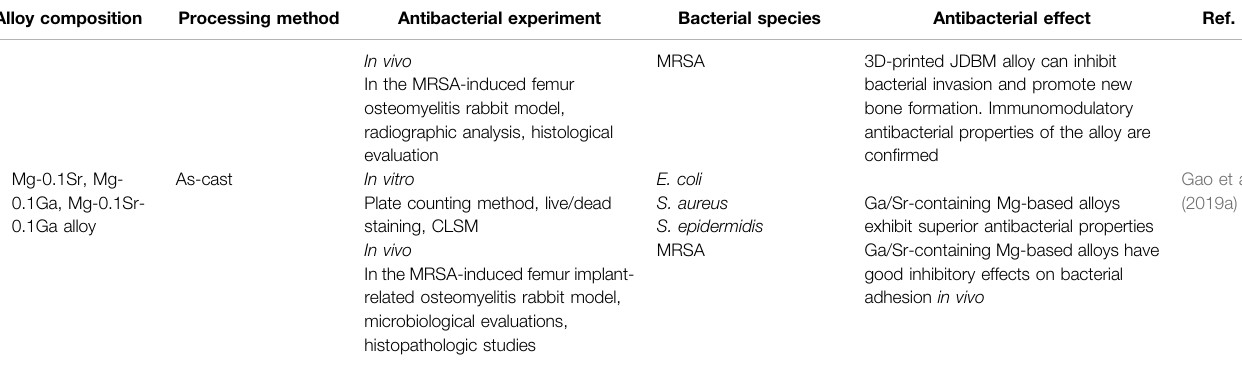
TABLE 1 | ( Continued ) Antibacterial properties of Mg-based alloys with antibacterial properties as orthopedic